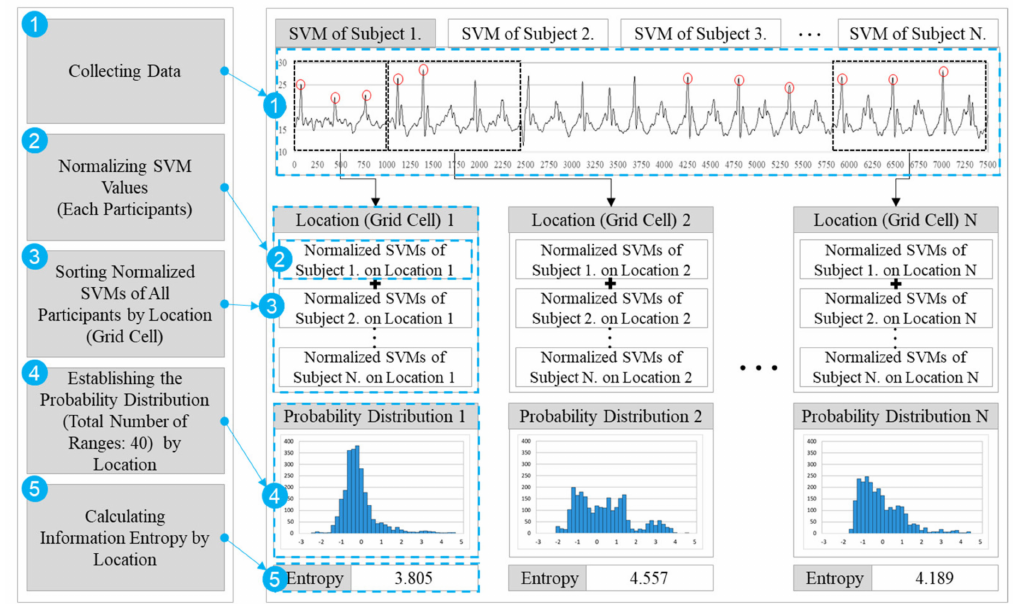
Figure 1. Example of the calculation process of